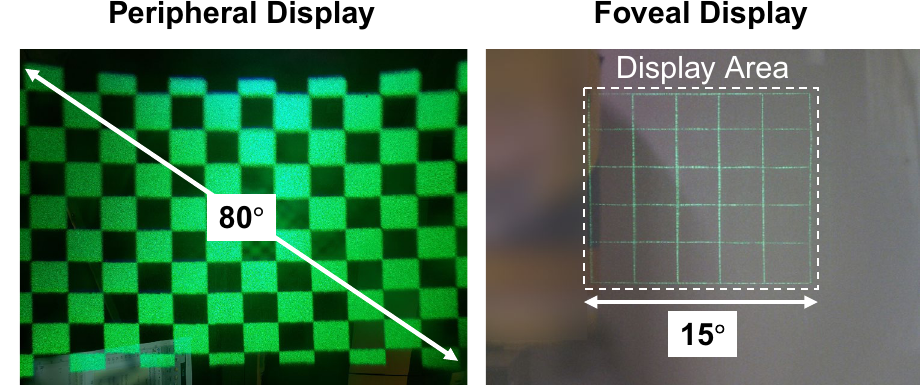
Figure 5. Field of view evaluation of the implemented peripheral and foveal